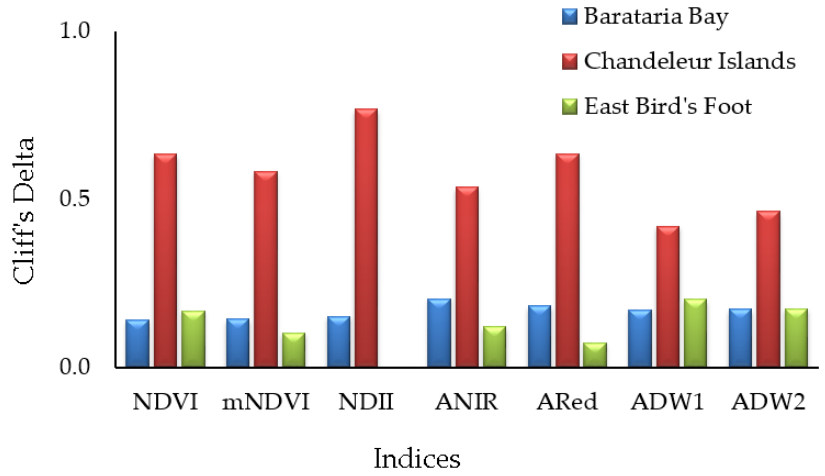
Figure 5. The difference in effect size (Cliff’s delta) between the three sites for seven spectral